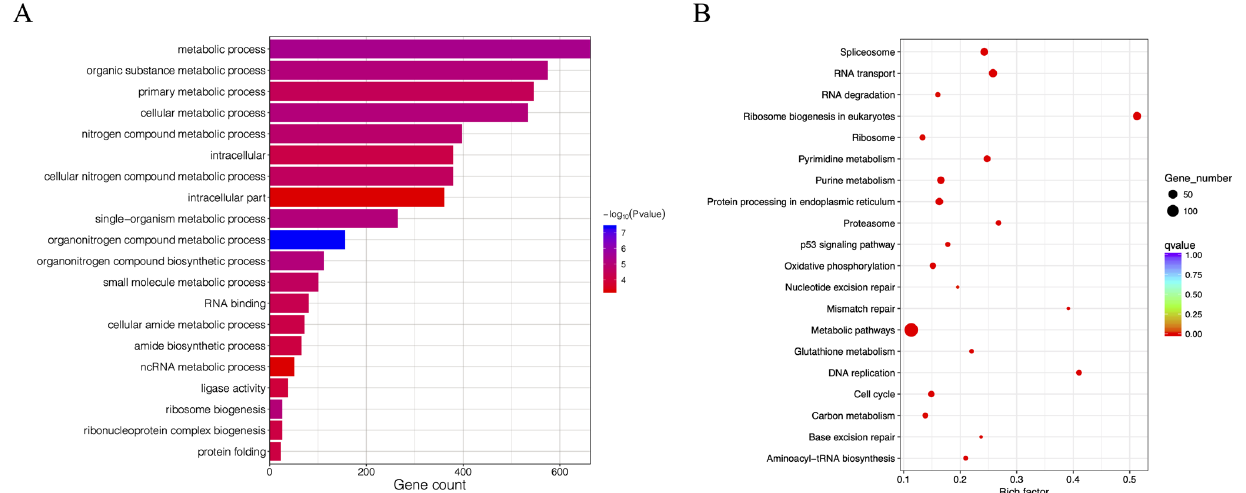
Figure 8. GO and KEGG enrichment of differentially expressed genes (DEG) between CSBV Bces- Po19-sensitive and -resistant Japanese flounder ( Paralichthys olivaceus ). ( A ) GO enrichment of DEGs. The names of the GO categories are listed along the y -axis; the degree of GO enrichment is represented by the − log 10 ( p -value). ( B ) KEGG enrichment of DEGs. The x -axis represents the gene ratio, which is a proportion of the DEGs out of the total genes in a KEGG term. y -axis is the gene function classification of KEGG. Different plot colors indicate different q values. Plot diameter represents the DEG numbers in a KEGG term.